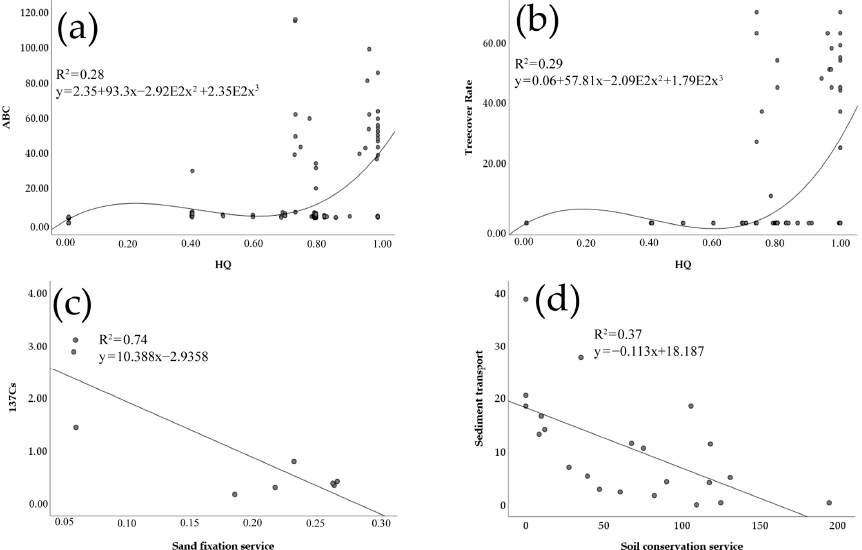
Figure 3. Validation of ( a , b ) the InVEST model (habitat quality), ( c ) the RWEQ model (sand fixation service), ( d ) the RUSLE models (soil conservation service); habitat quality (HQ), above ‐ ground biomass carbon (ABC), Cesium (Cs), Revised Universal Soil Loss Equation (RUSLE), Revised Wind Erosion Equation (RWEQ), Integrated Valuation of Ecosystem Services and Trade ‐ offs (InVEST).